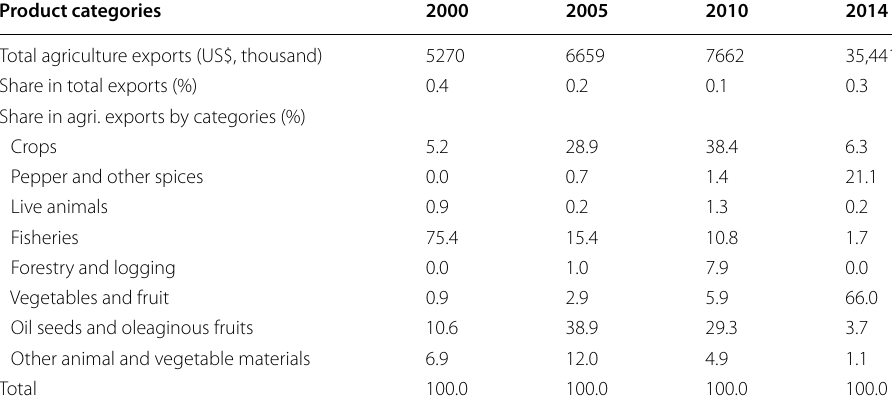
Table 1 Agriculture export by categories (2000–2014). Source : UN Comtrade (2016),